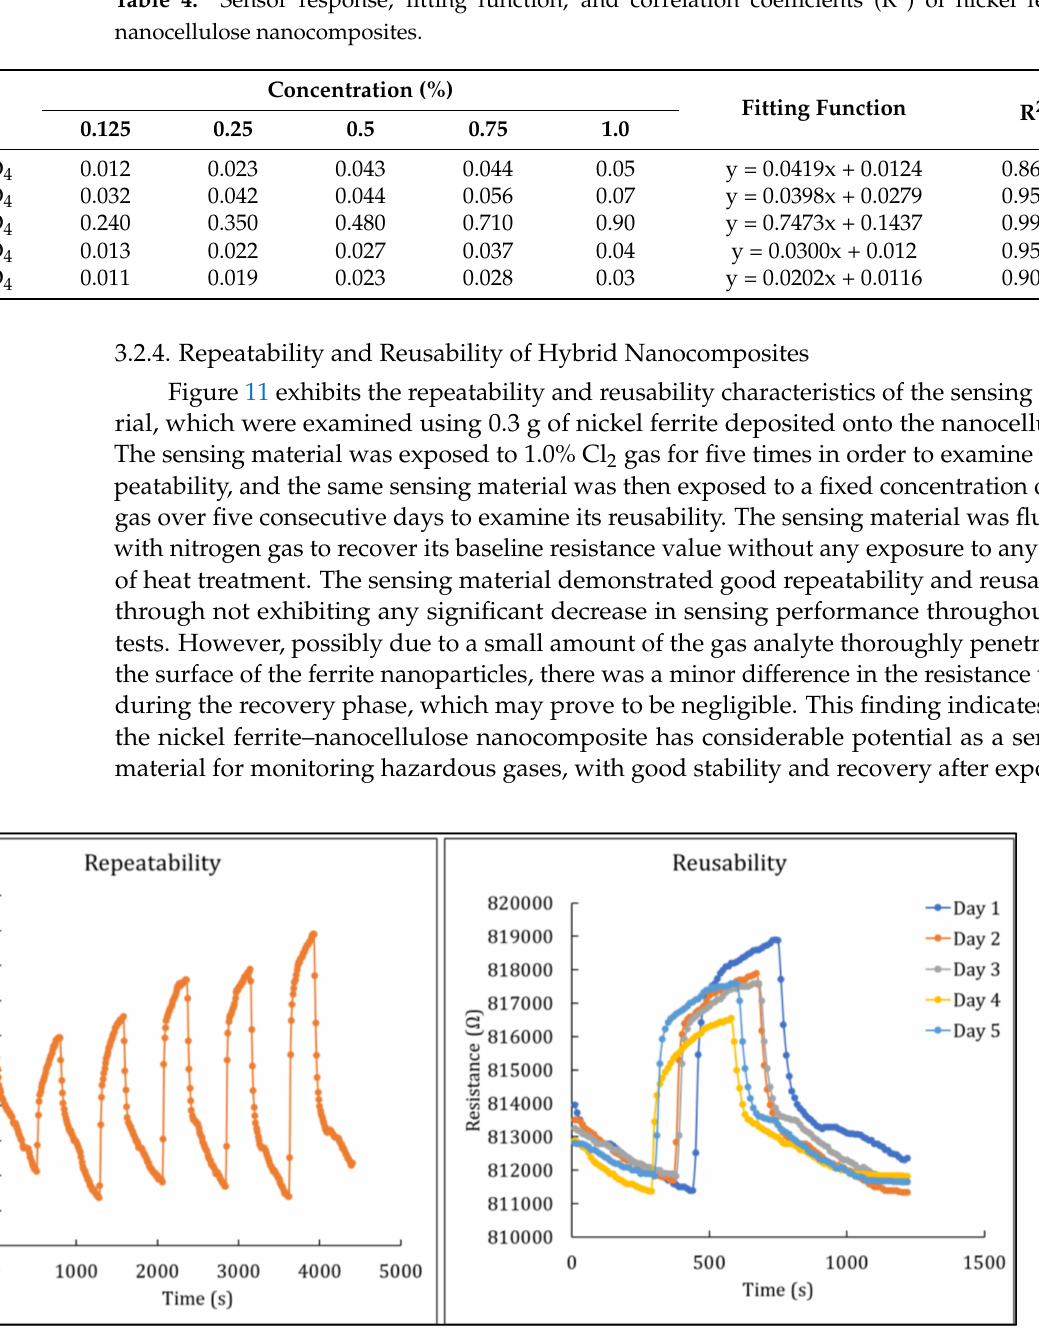
Table 4. Sensor response, fitting function, and correlation coefficients (R 2 ) of nickel ferrite–